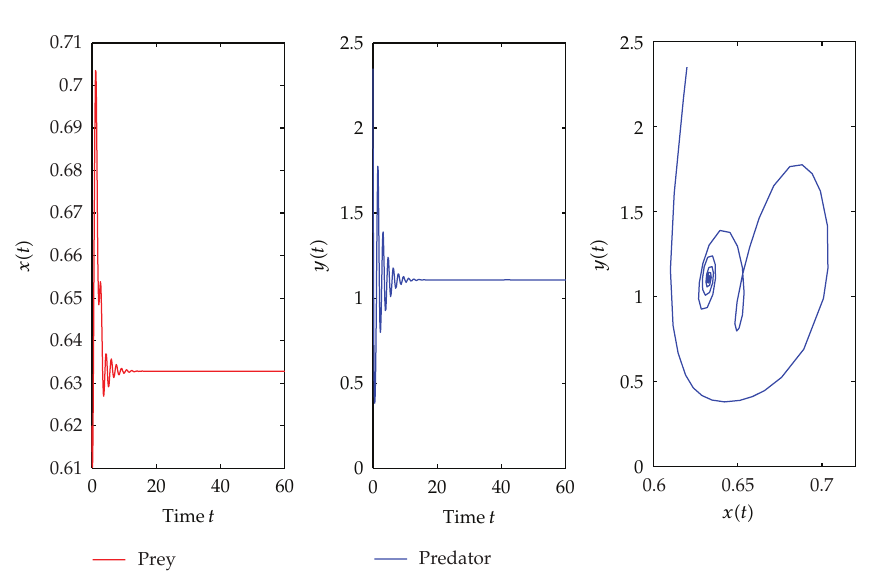
Figure 3: E ∗ is stable for τ 1 (cid:5) 0 . 8 < τ 1 ∗ (cid:5) 2 . 3211 ,τ 2 (cid:5) 0 . 36 with initial value 0.62,2.35.